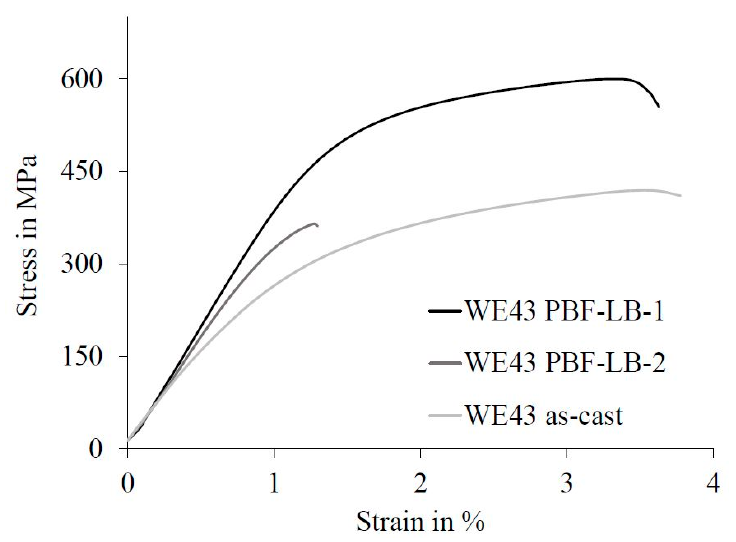
Figure 12. Stress–strain diagram of as-cast and PBF-LB-generated WE43 under bending load. Table 5. Mechanical properties of as-cast and PBF-LB-generated WE43 parts.